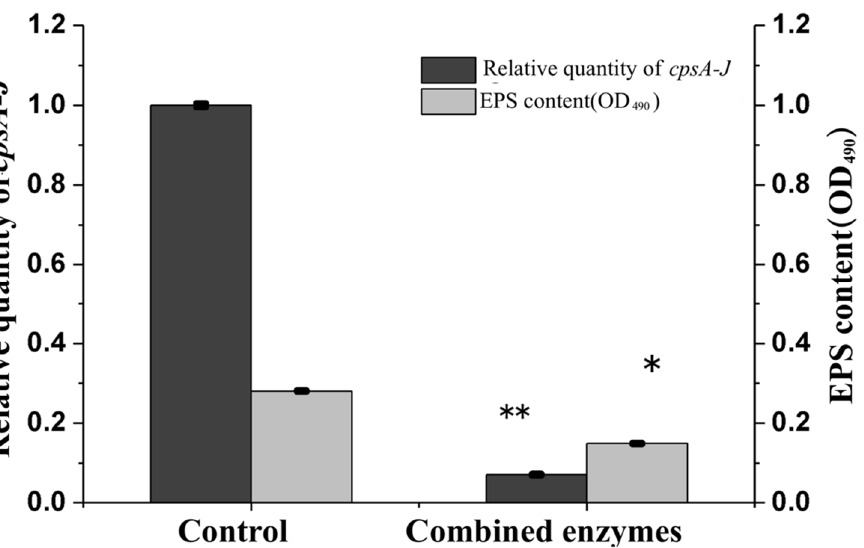
Figure 5. Effects of combined enzymes on exopolysaccharide (EPS) concentration and cpsA-J mRNA’s relative expression of V. parahaemolyticus incubated in 24-well microplates. * p < 0.05, ** p < 0.01. Three technical replicates and three biological replicates were conducted.